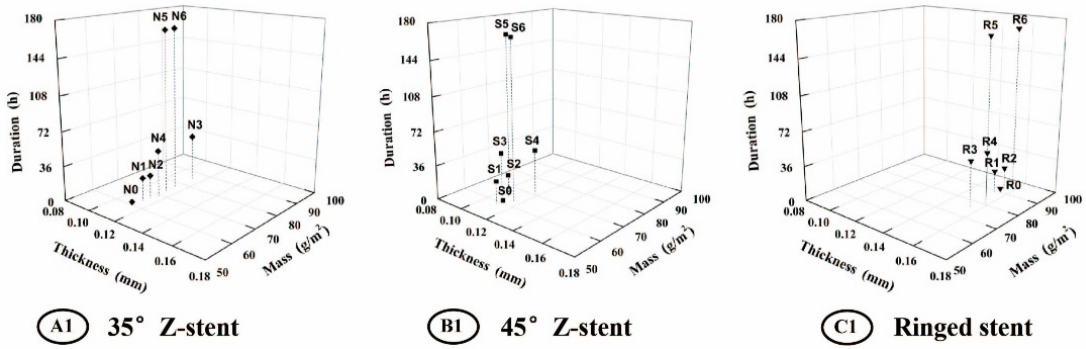
Figure 9. Thickness and mass of the fabrics of the stent ‐ grafts. ( A1 ) 35° Z ‐ stent; ( B1 ) 45° Z ‐ stent; ( C1 ) Ringed stent.